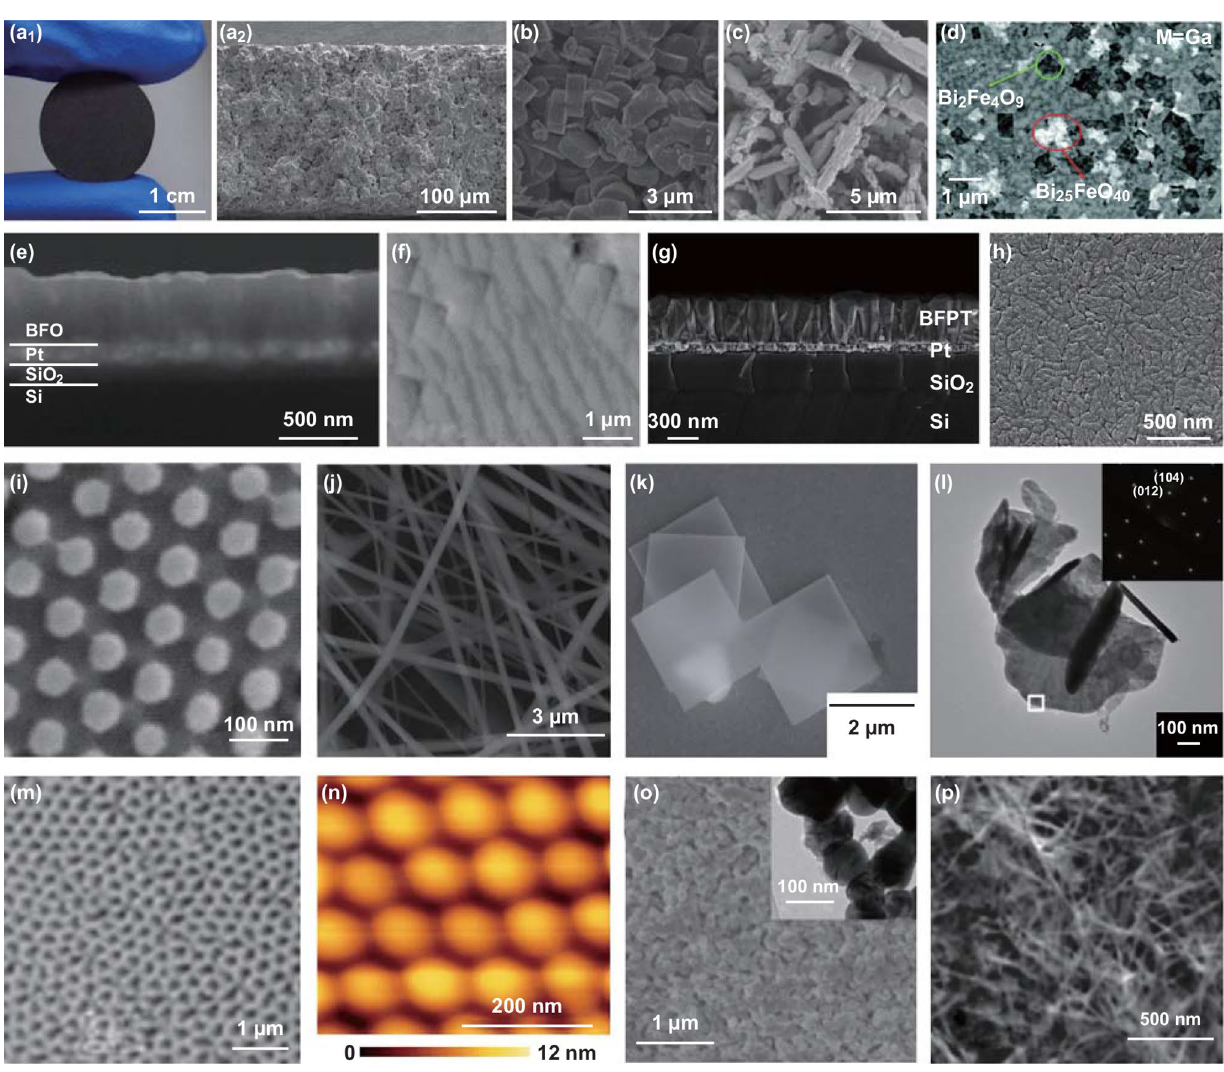
Fig. 1 Various forms of BFO‑based nanomaterials. a – d Photographs and SEM images of the BFO ceramic. Adapted with permission from Refs. [19–22]. e – h SEM images of BFO thin films. Adapted with permission from Refs. [18, 24, 25]. The morphologies of different BFO nano‑ structures including i nanodots, j nanofibers, k nanosheets, i nanoplate, m nanotubes, n nanoislands, o nanoparticles, and p nanowires. Adapted with permission from Refs. [31–34,